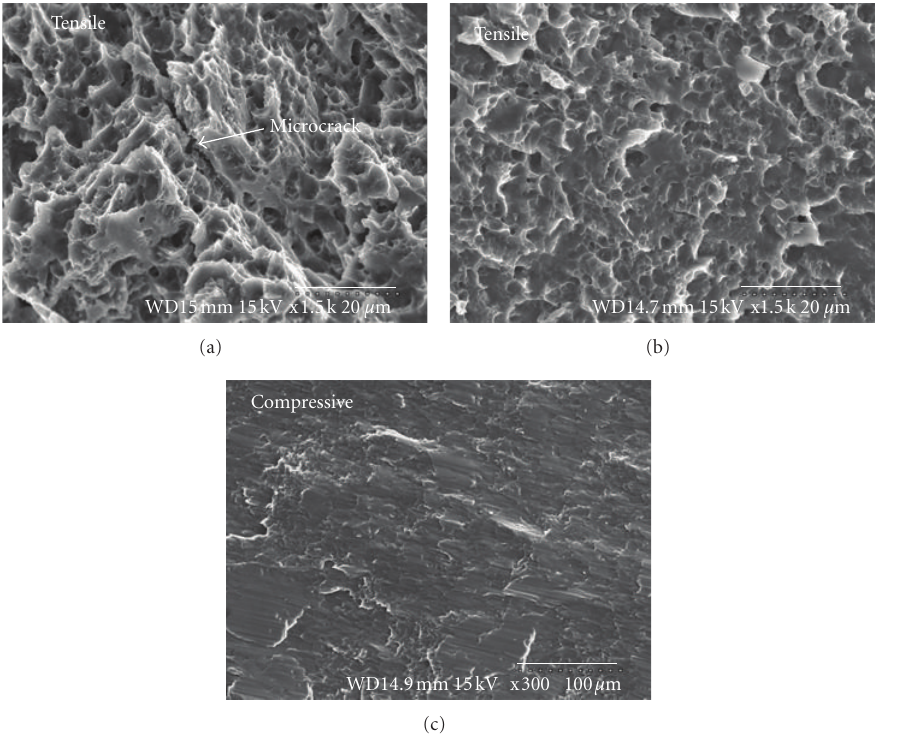
Figure 5: Representative tensile fractographs of (a) monolithic AZ31/AZ91 and (b) AZ31/AZ91/TiC nanocomposite. (c) Representative compressive fractograph of monolithic AZ31/AZ91 and AZ31/AZ91/TiC nanocomposite.